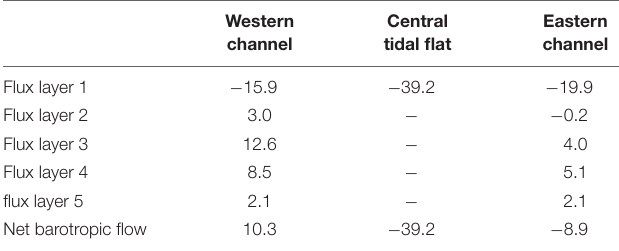
TABLE 3 | Yearly mean volume fluxes through the three different portions of the section at the opening of the Goro Lagoon ( Figure 1 ).